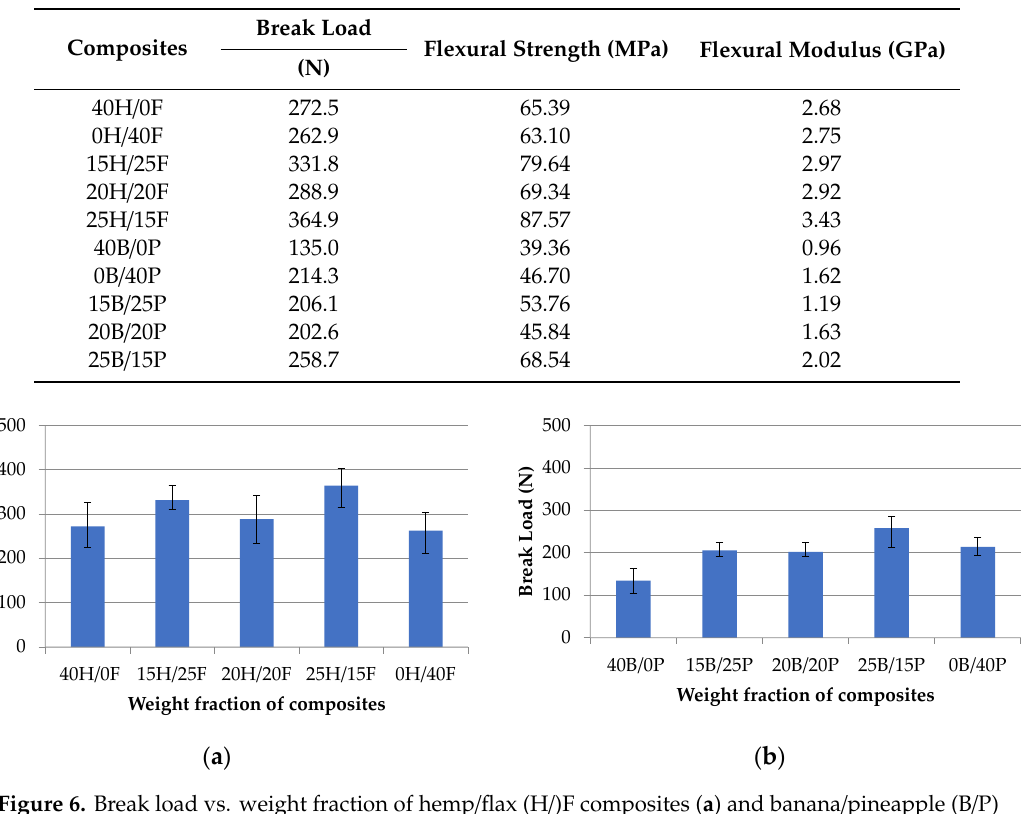
Table 3. Flexural strength properties.